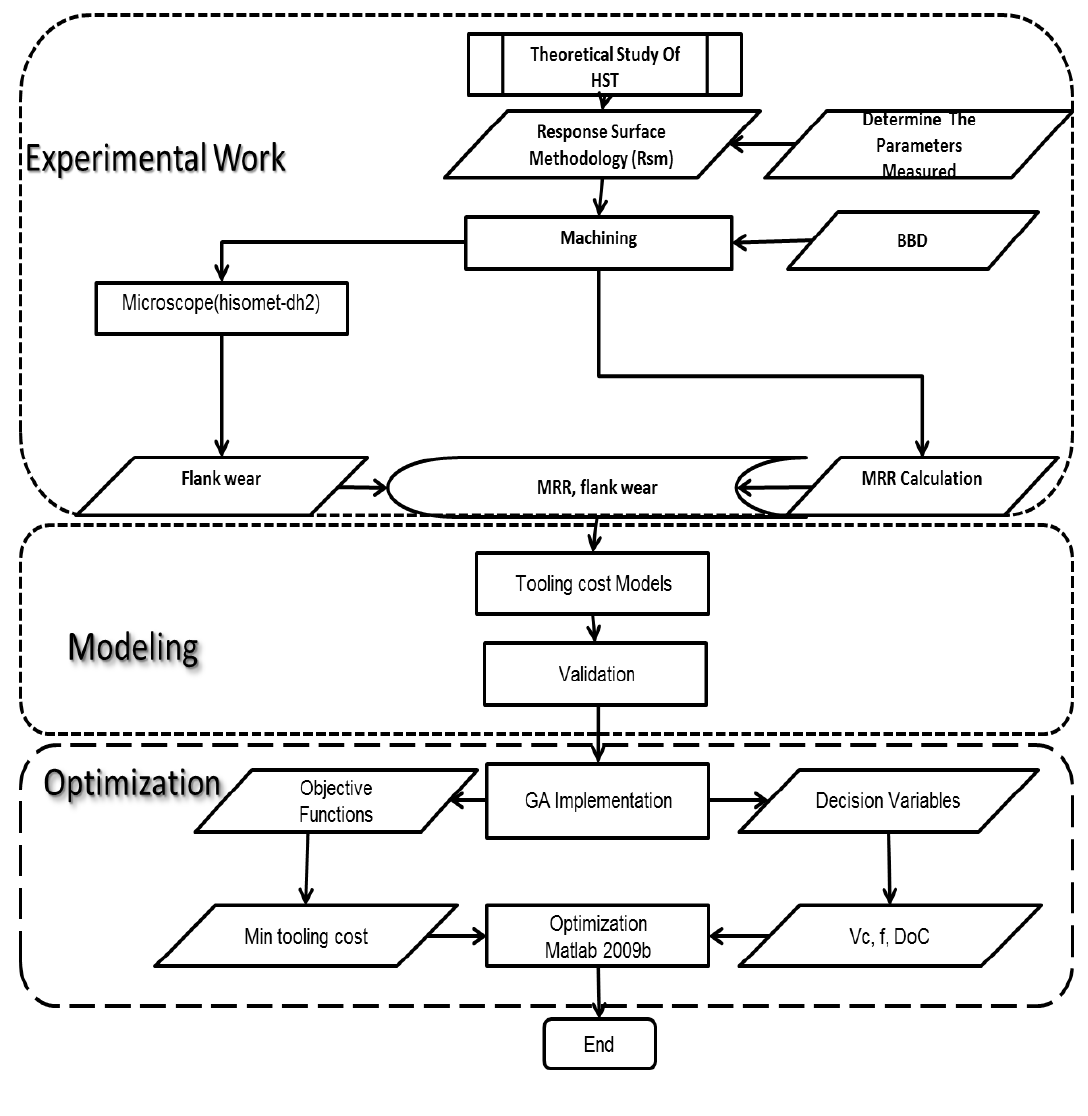
Figure 1: Research